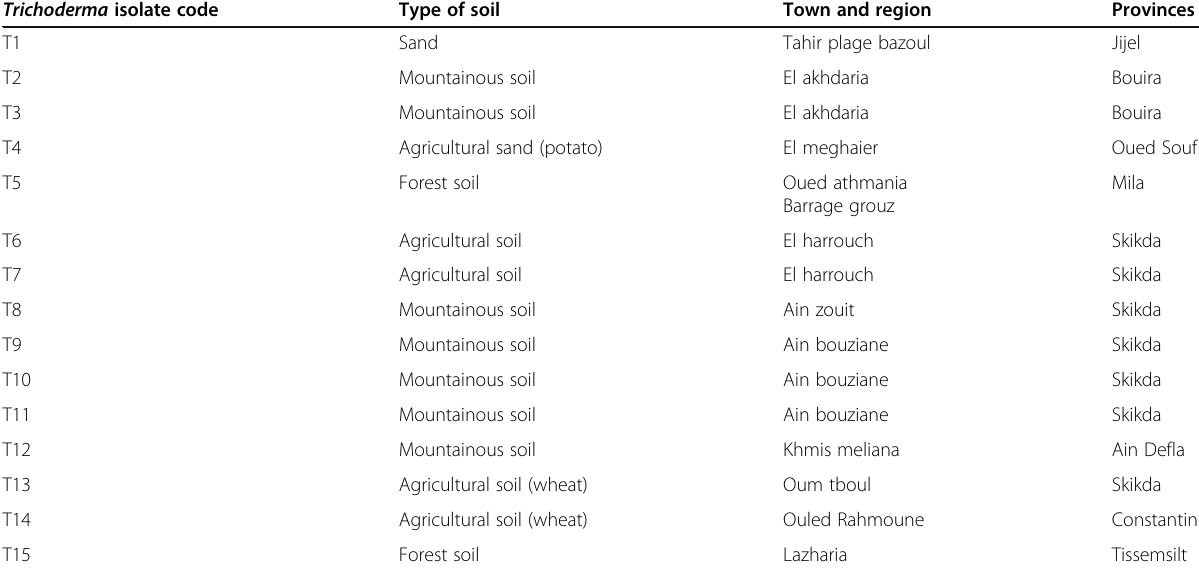
Table 1 Code of Trichoderma isolates, with the soil type, region, and province of their isolation Trichoderma isolate code